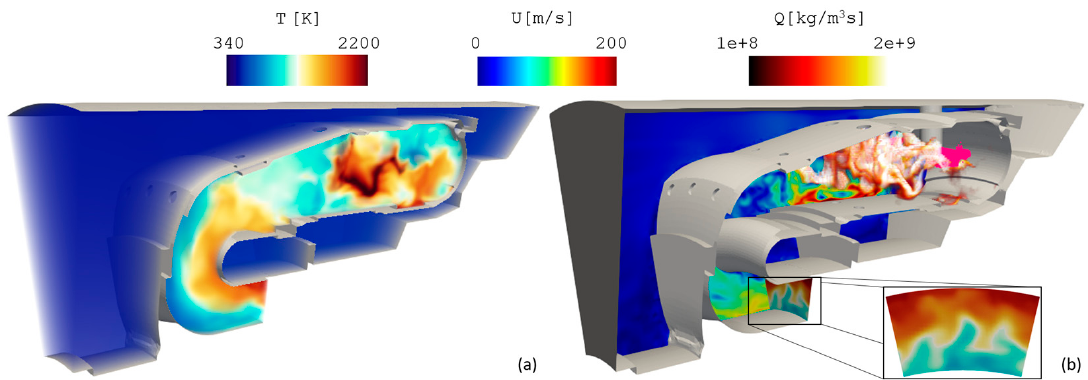
Figure 15. ( a ) Volumetric rendering of the instantaneous temperature in the combustor for C1 and ( b ) instantaneous velocity magnitude, U , on the cyclic patch and the temperature, T , on the outlet; instantaneous volumetric rendering of the heat release, Q , and spray (magenta).